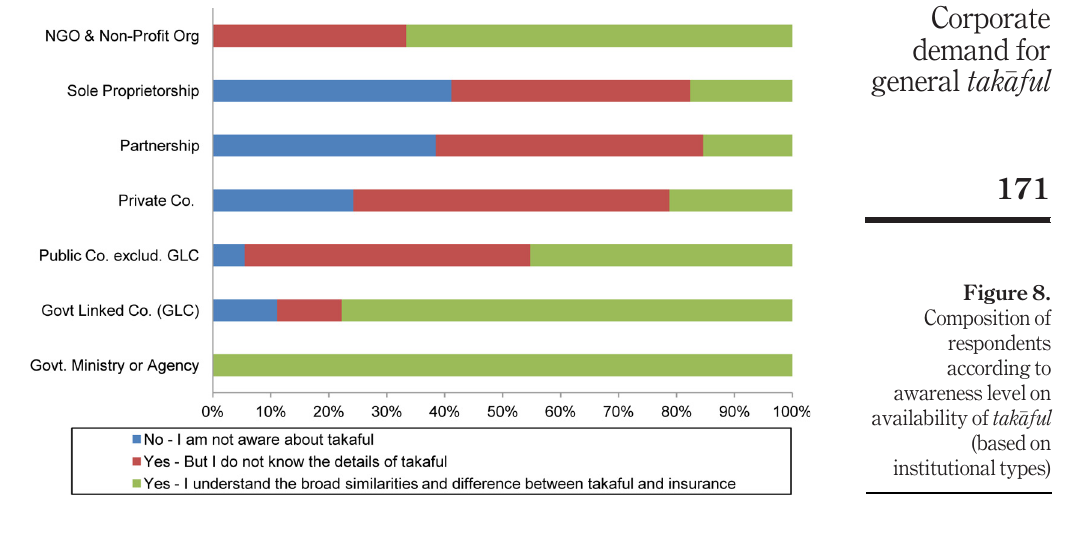
Figure 9. Composition of respondents according to their willingness to obtain tak (cid:1) aful or insurance coverage